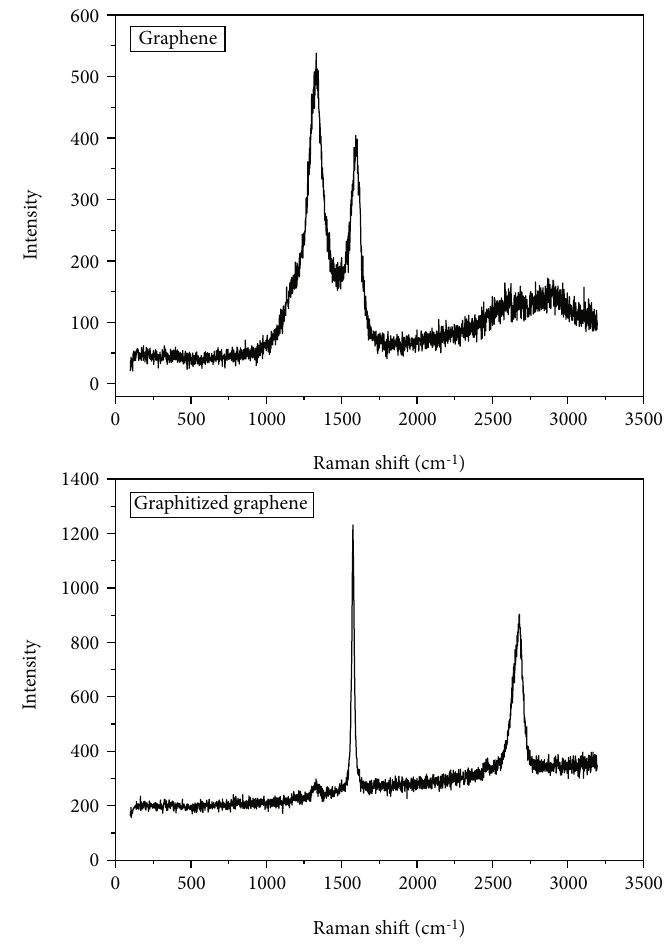
Figure 4: Raman spectrum of graphene and graphitized graphene.